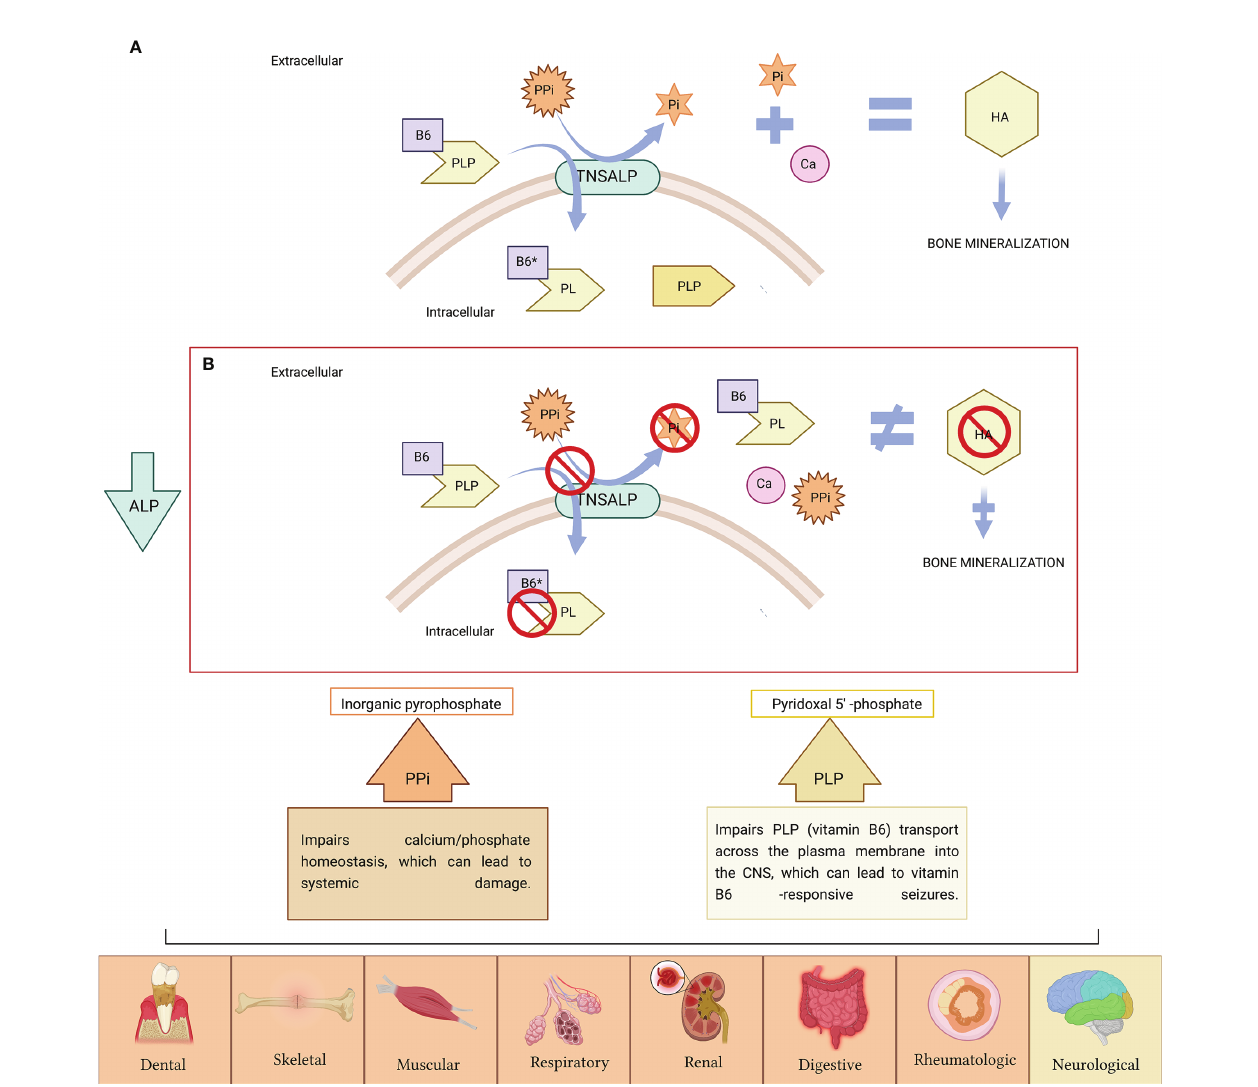
FIGURE 1 | (A) TNSALP is attached to the cell membrane, where it degrades inorganic pyrophosphate (PPi) to inorganic phosphate (Pi), needed for hydroxyapatite (HA) crystal formation and further bone mineralization. TNSALP hydrolyses PLP (active form of B6) to pyridoxal (PL) in order to cross the cell membranes, after which is, then intracellularly rephosphorylated into PLP. (B) PPi is not degraded to Pi. Excess of PPi inhibits HA crystal formation with further inhibition of bone mineralization. PLP is not hydrolyzed to pyridoxal (PL), and accumulates extracellularly. The low activity of ALP causes the accumulation of PPi and PLP, causing symptoms in various organs of the human body (the symptoms related to PPi accumulation appears in orange boxes while symptoms related to PLP accumulation as vitamin B6 de fi ciency are indicated in yellow box). Figure created with